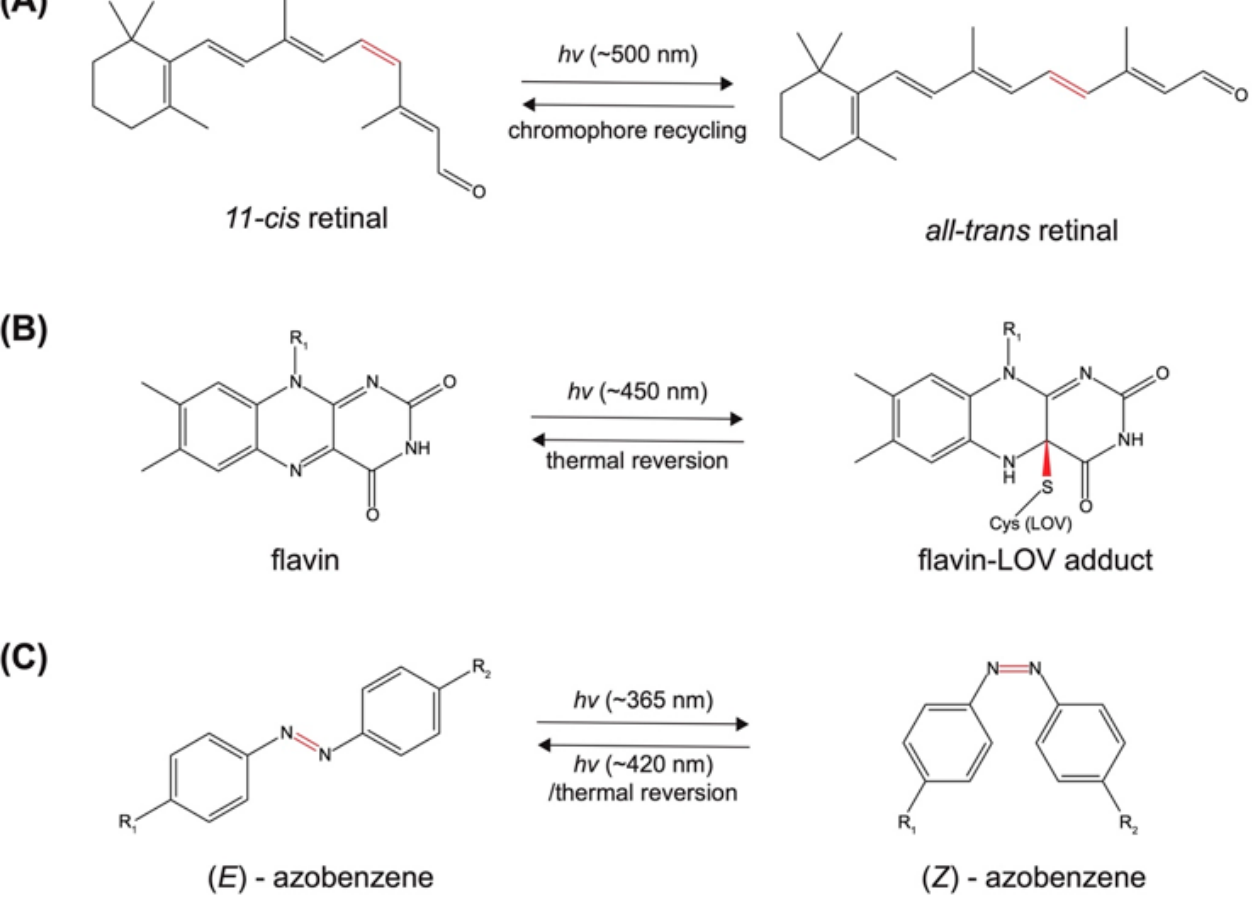
Figure 2. Representative examples of photoreceptor and non-photoreceptor derived photoswitches. ( A ) Isomerization of retinal in opsins. ( B ) Light-induced binding of flavin to LOV domain of naturally occurring photoreceptors. ( C ) Isomerization of azobenzene between the Z and E conformations. Light-sensitive covalent bonds are colored red.